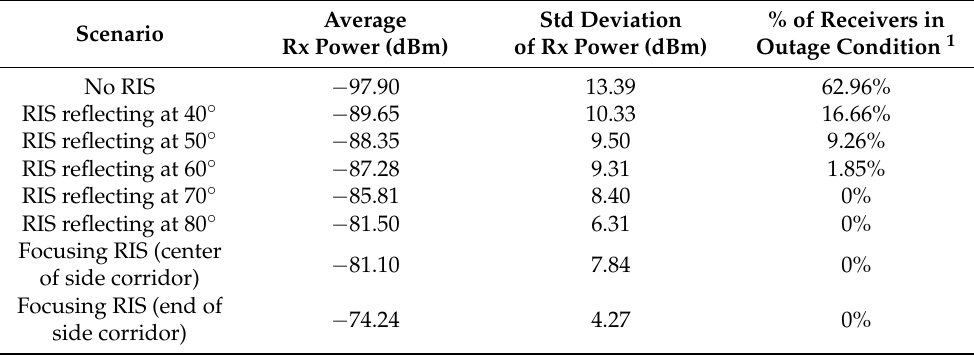
Table 2. Coverage levels in the L-corridor scenario for different configurations of the RIS.